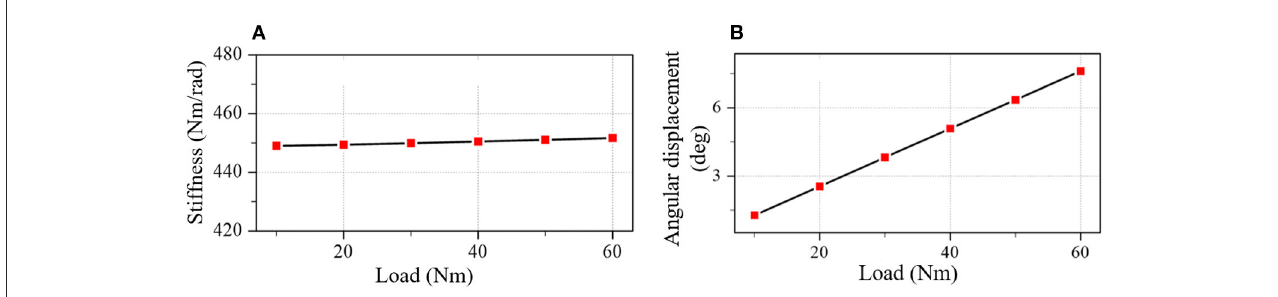
FIGURE7 The stiffness and angular displacement of the optimal coupler. (A) Stiffness. (B) Angular